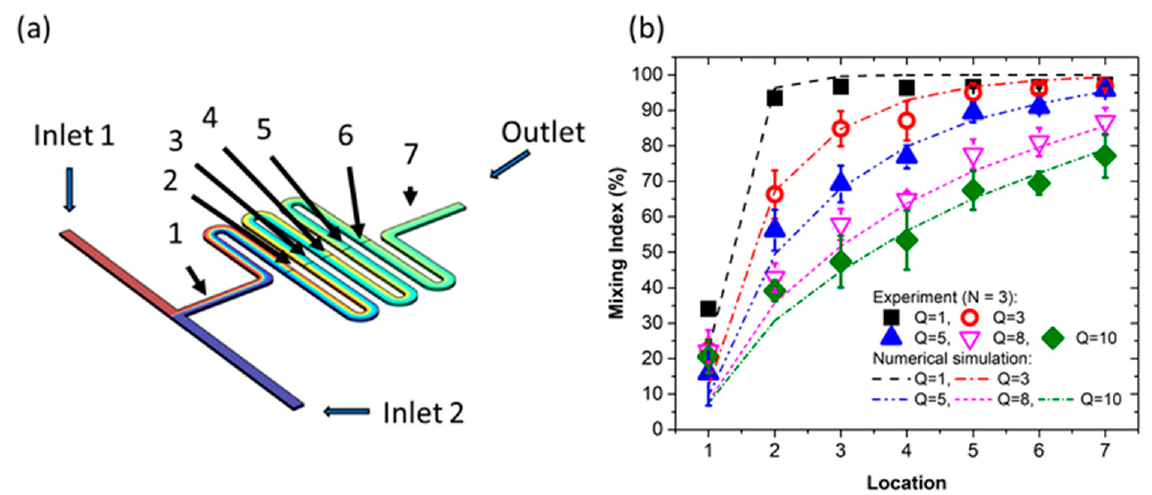
Figure 3. ( a ) Concentration contour distribution via numerical simulation. ( b ) Mixing index (MI) at different locations along the microchannel as function of flow rate (Q: μ L/min). Experimental and numerical simulation results mutually agree well. Over 95% mixing index can be obtained for a flow rate lower than 5 μ L/min at detection location #7.